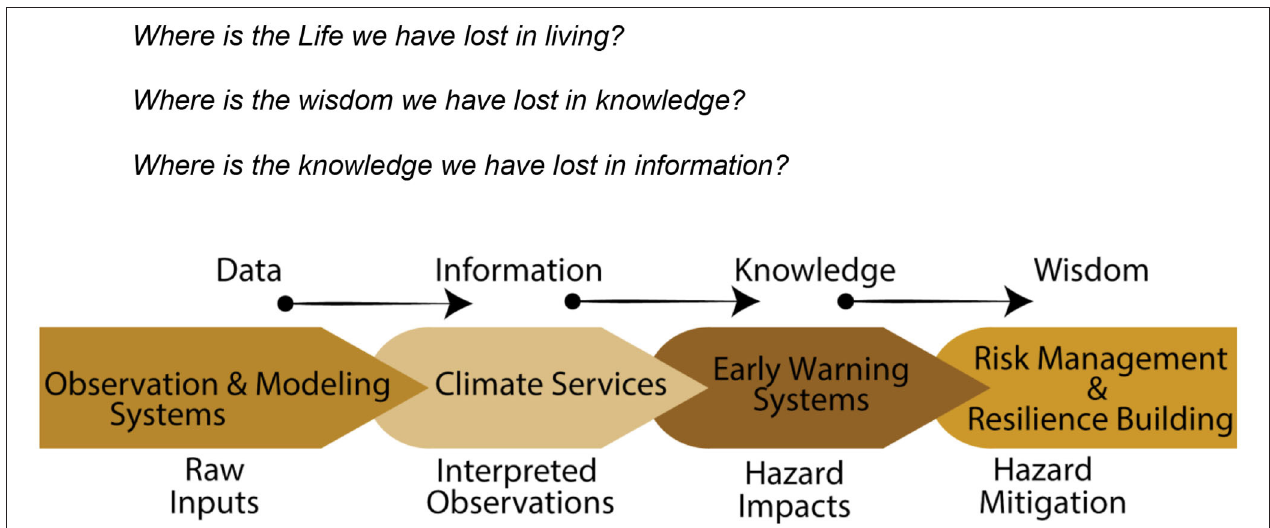
FIGURE 1 | A schematic diagram showing how multiple communities of practice can all contribute to effective hazard mitigation, risk management, and